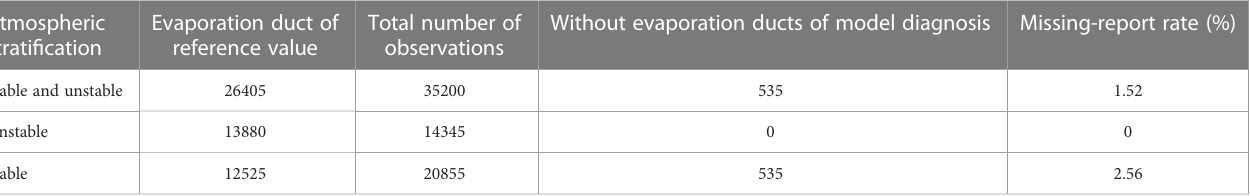
TABLE 3 Evaporation duct missing-report